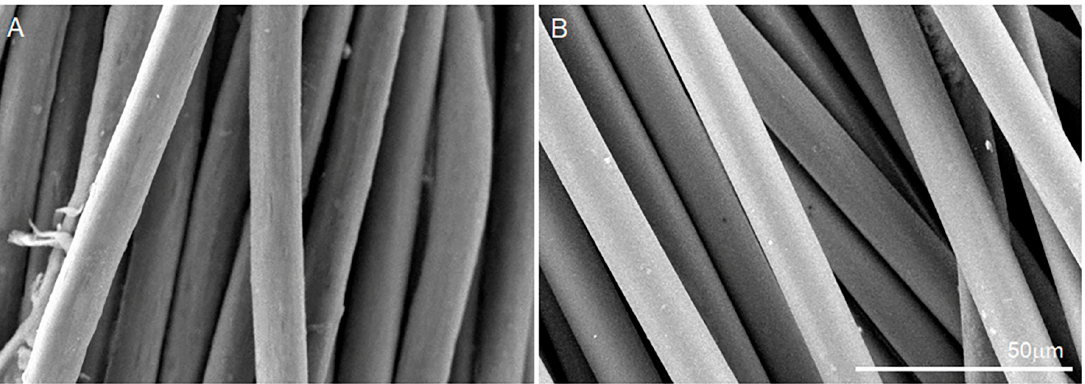
Figure 1. Representative SEM images of ( A ) collagen and ( B ) PLA scaffolds at 1000× magnification. Scale bars = 50 μ m.